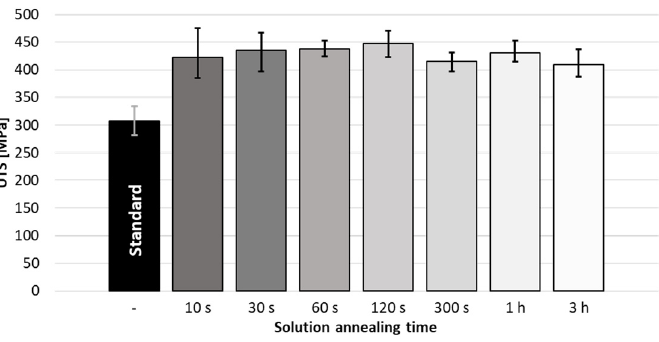
Figure 8. Influence of solution annealing time during PWHT on the UTS of the welding seam.